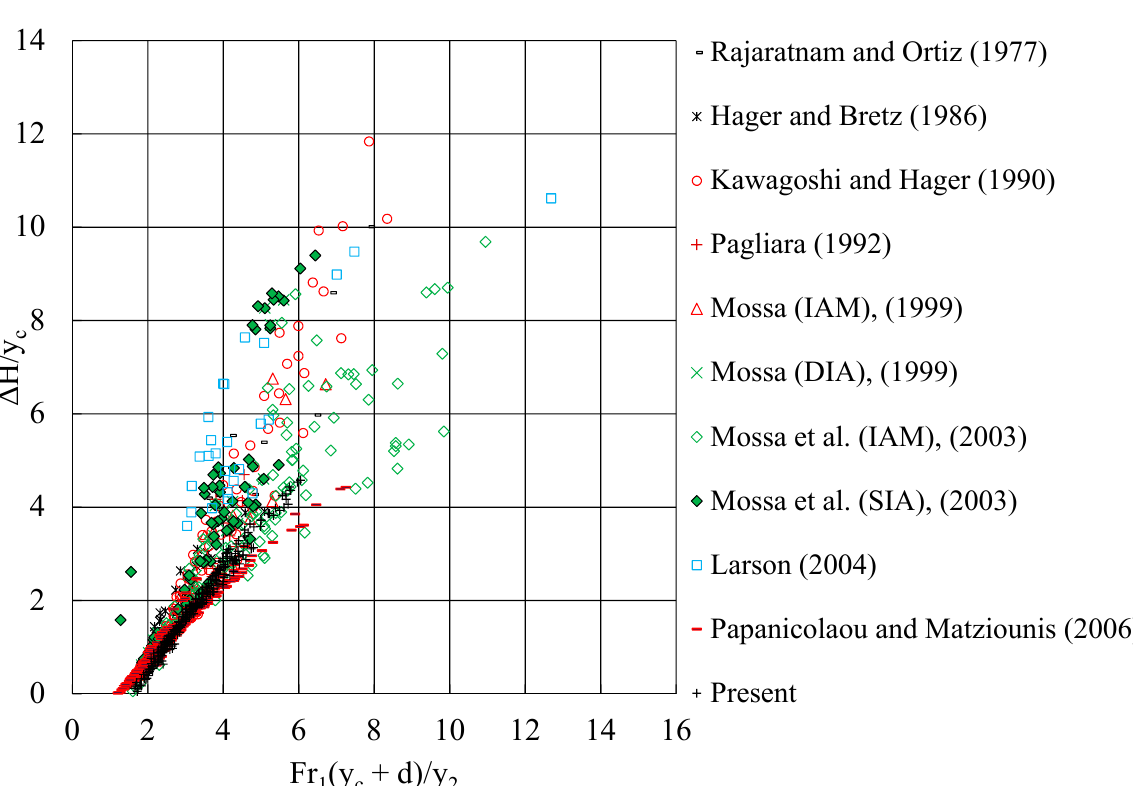
distance from bottom. The pressure was extrapolated linearly to the top and bottom of flow, minimum B-jump and B-jump, while it was positive on the face of the step for the wave-train, wave jump and A-jump. The normalized pressure by the maximum pressure at the bottom was zero at the face of the step at dimensionless height y/(p/ ρ g) max ~ 1 from bottom, only for minimum B-jump and B-jump.